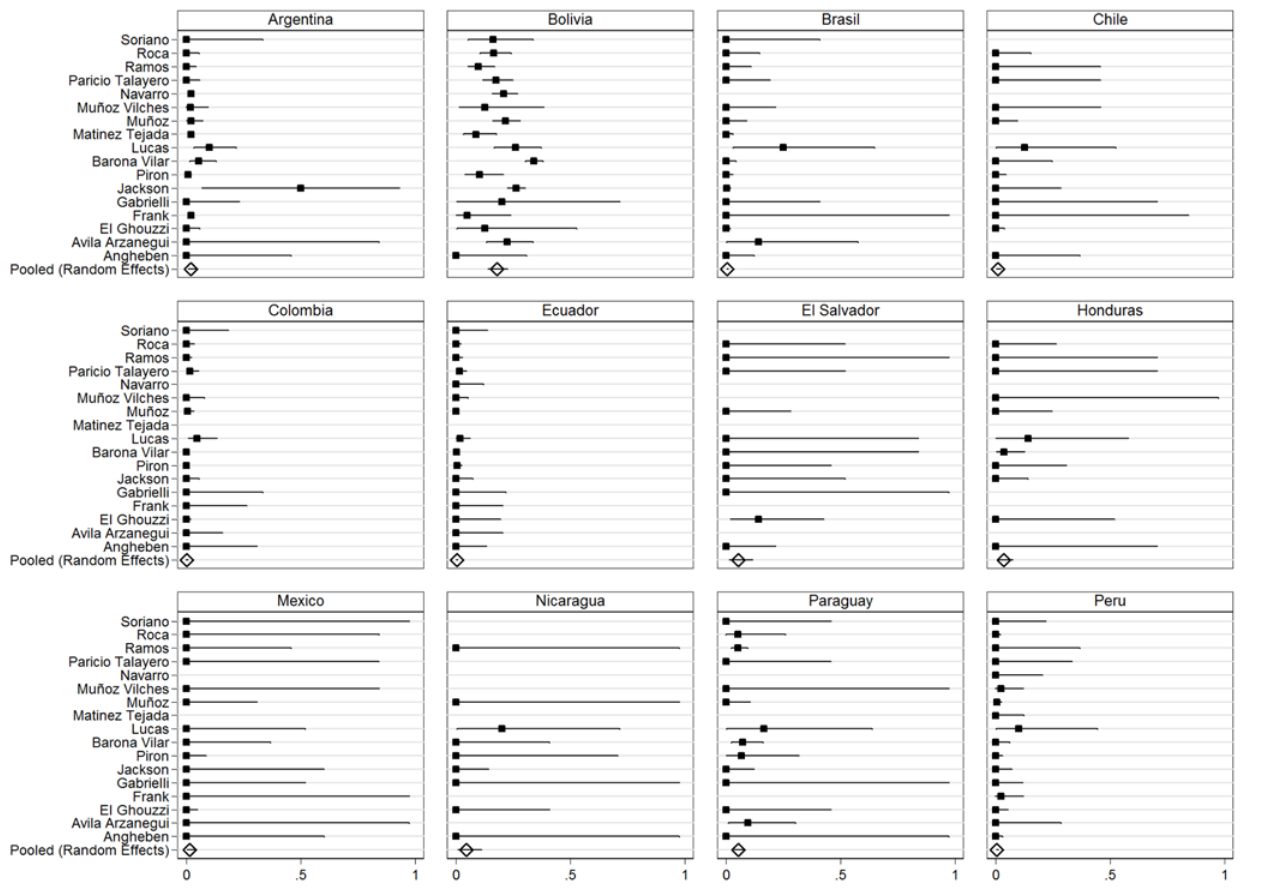
Fig 2. Forest plots of prevalence of Chagas disease by country of origin of Latin American